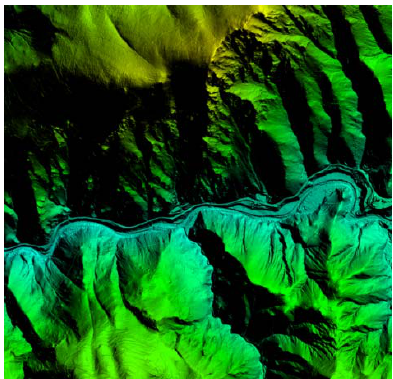
Figure 4. Example of generated DTM file of 2m grid resolution.